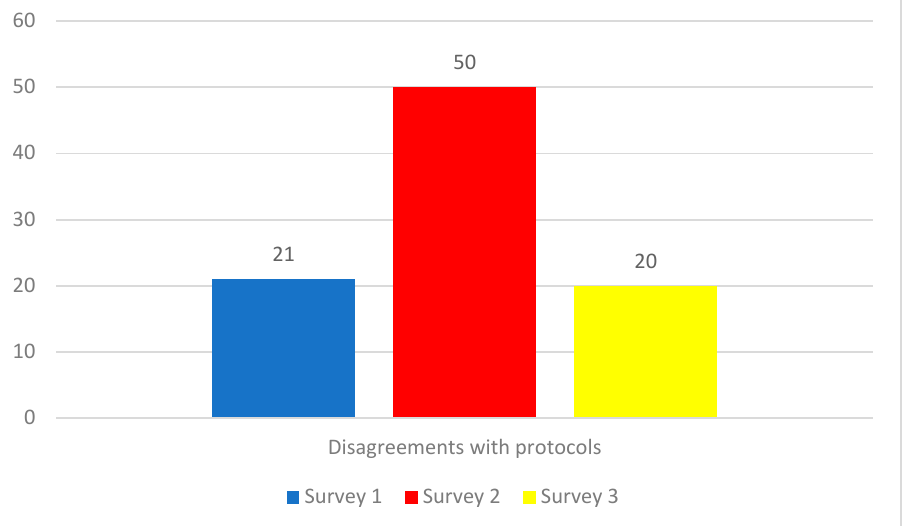
Figure 5. Number of responses corresponding to theme 3: Disagreement with COVID-19 protocols. Since participants could select multiple themes, it is not possible to calculate percentages.